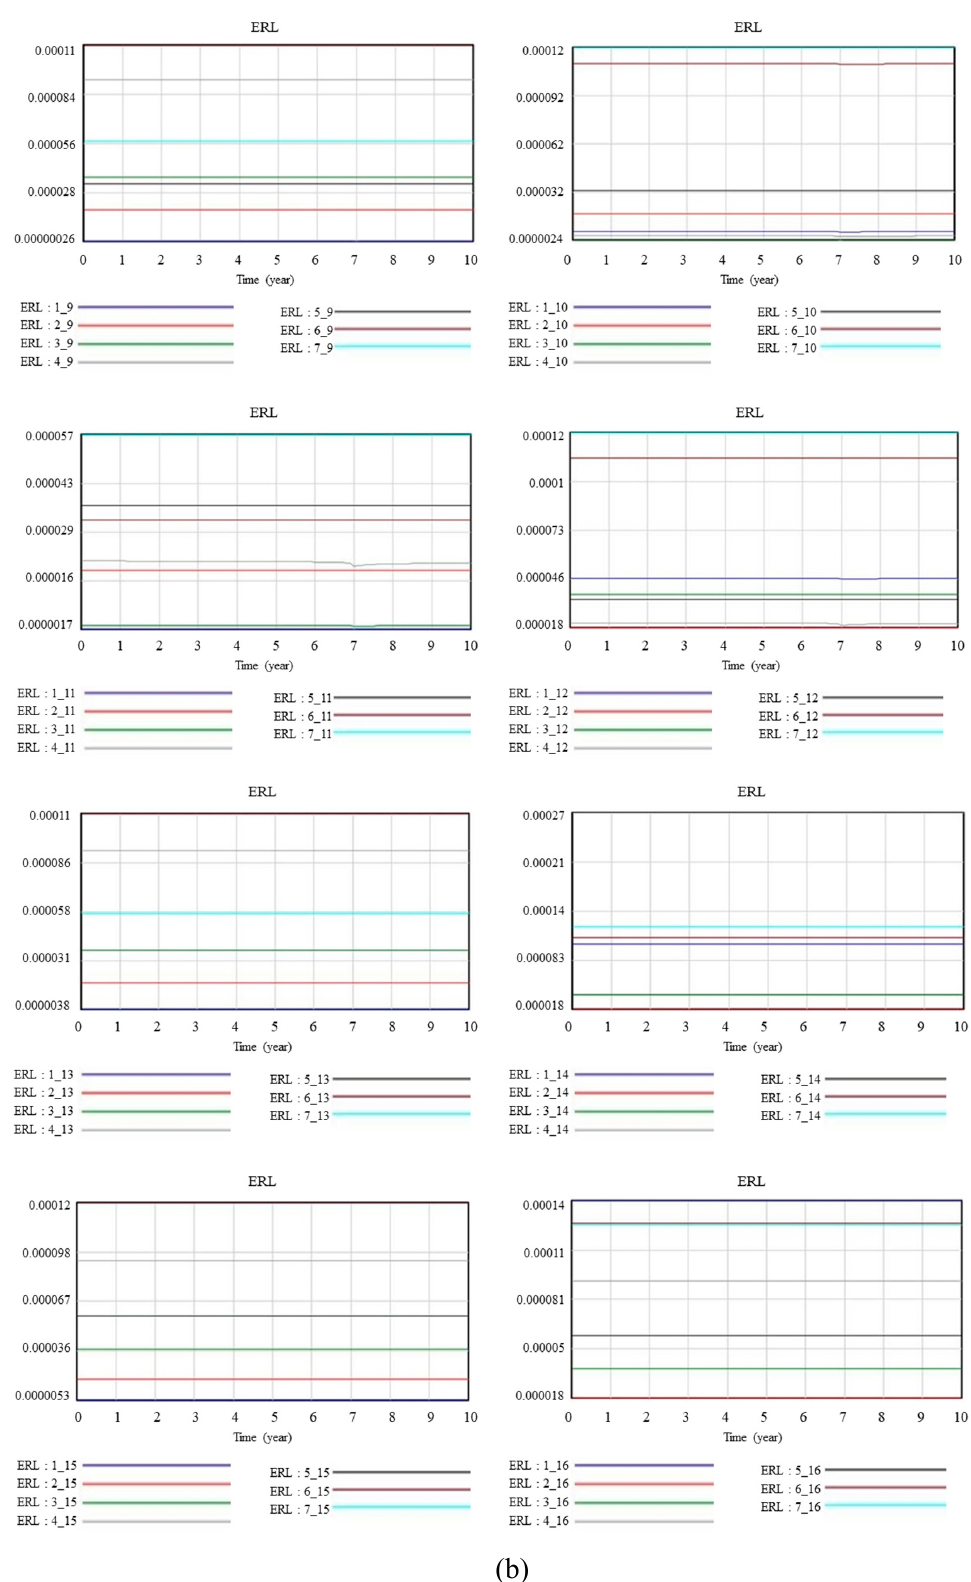
Figure 7. ( a ): SD plots—ERL variations over time for Trial Designs 01–08, Case #1 to #7. ( b ): SD plots— ERL variations over time for Trial Designs 09–16, Case #1 to #7.